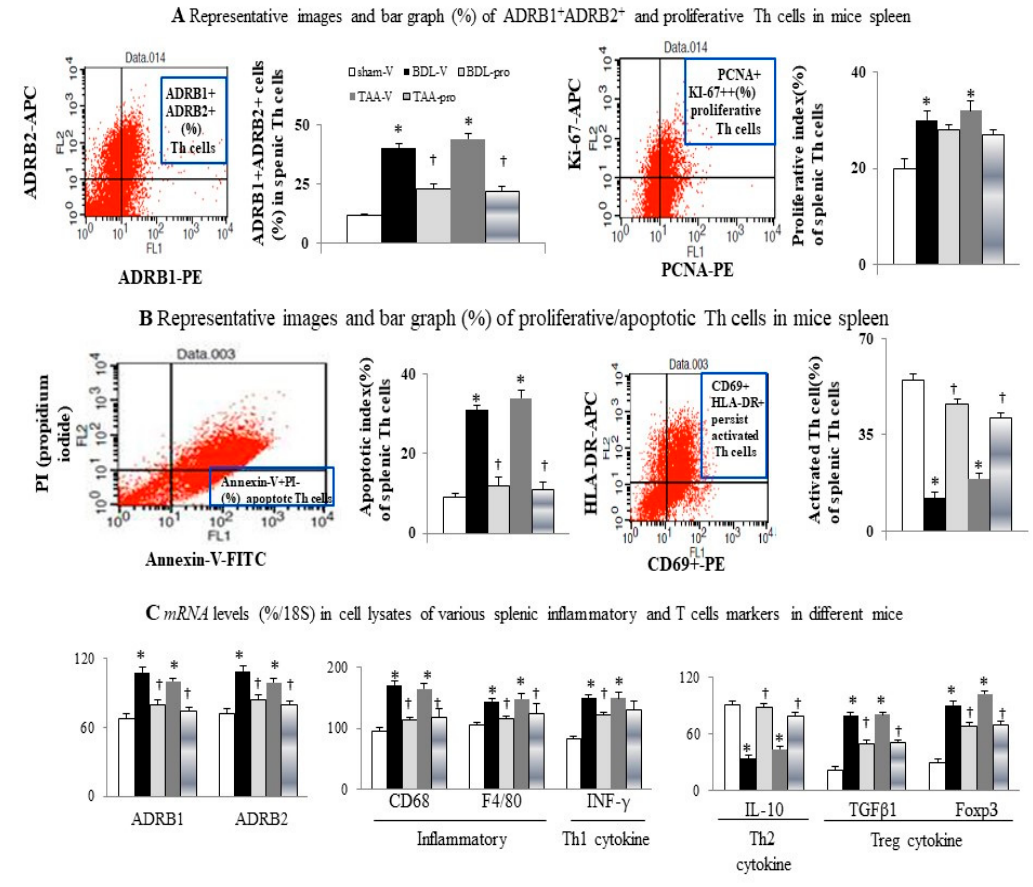
Figure 4. Increased percentage of ADRB1 + ADRB2 + cells was associated with increased percentage of proliferative/apoptotic Th cells and decreased activated Th cells in spleen of cirrhotic mice. The percentage distribution of ( A ) ADRB1 + ADRB2 + and proliferative (Ki-67 + PCNA + ) Th cells among groups, and ( B ) apoptotic [Annexin-V + PI − ], and activated [HLA-DR + CD69 + ] Th cells among groups; ( C ) mRNAs level (% / 18S) in cell lysates of various splenic inflammatory and T cells markers of Th cells from di ff erent groups. * p < 0.05 vs. sham-V group; † p < 0.05 vs. BDL-V / TAA-V group.